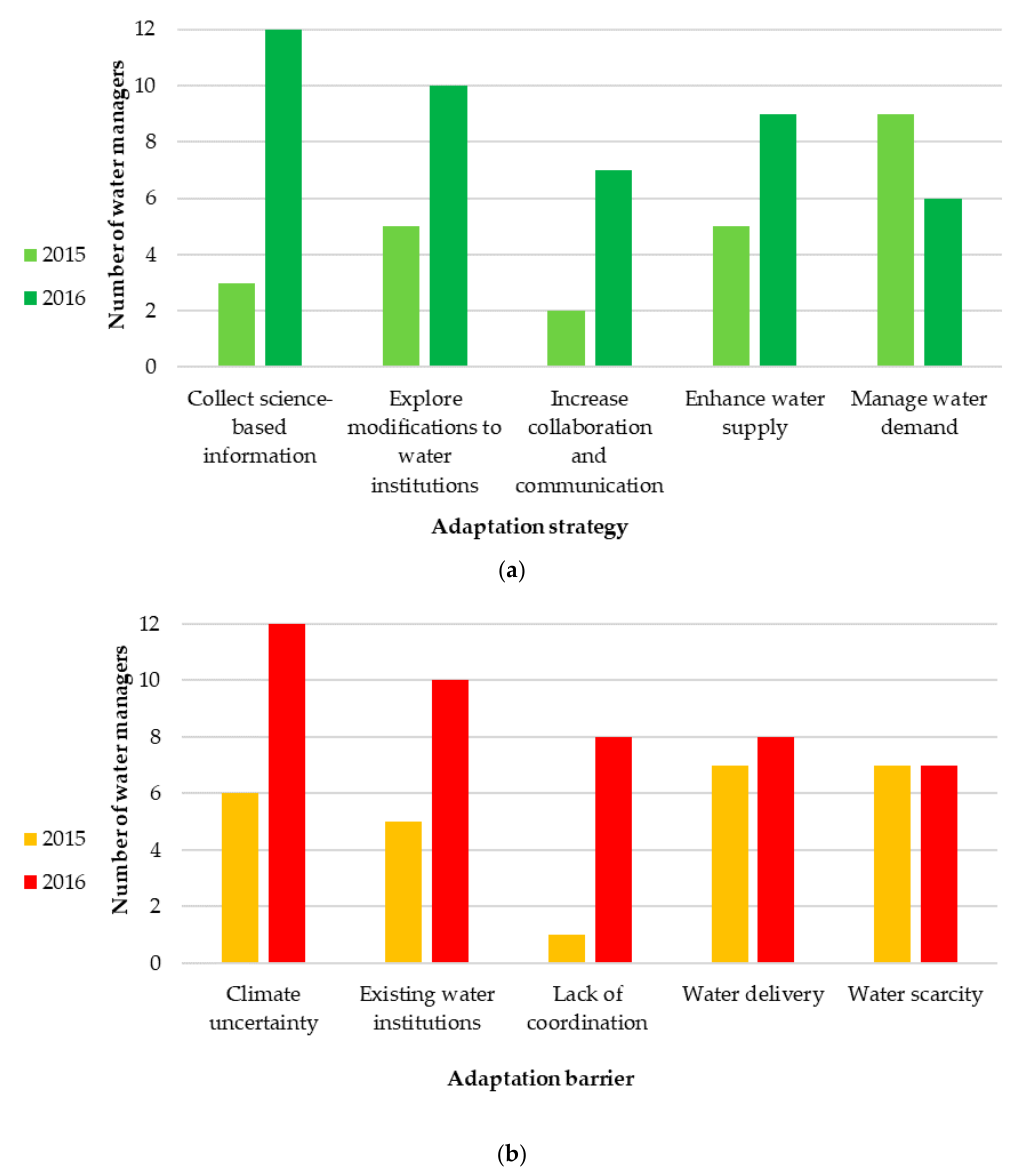
Figure 4. Shifts in adaptation strategies ( a ) and adaptation barriers ( b ) between 2015 and 2016.